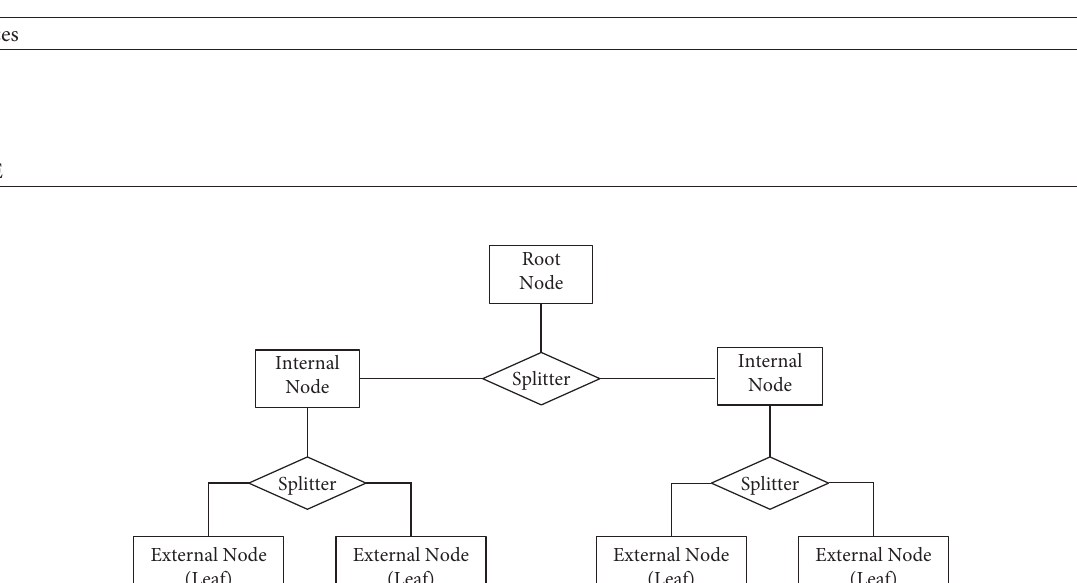
Table 4: Fit indices.